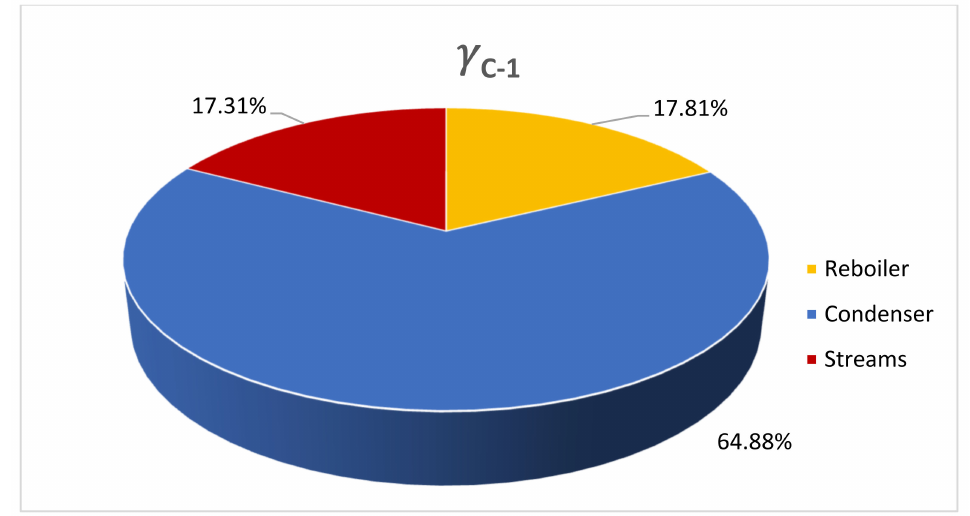
Figure 9. Distribution of destroyed exergy in